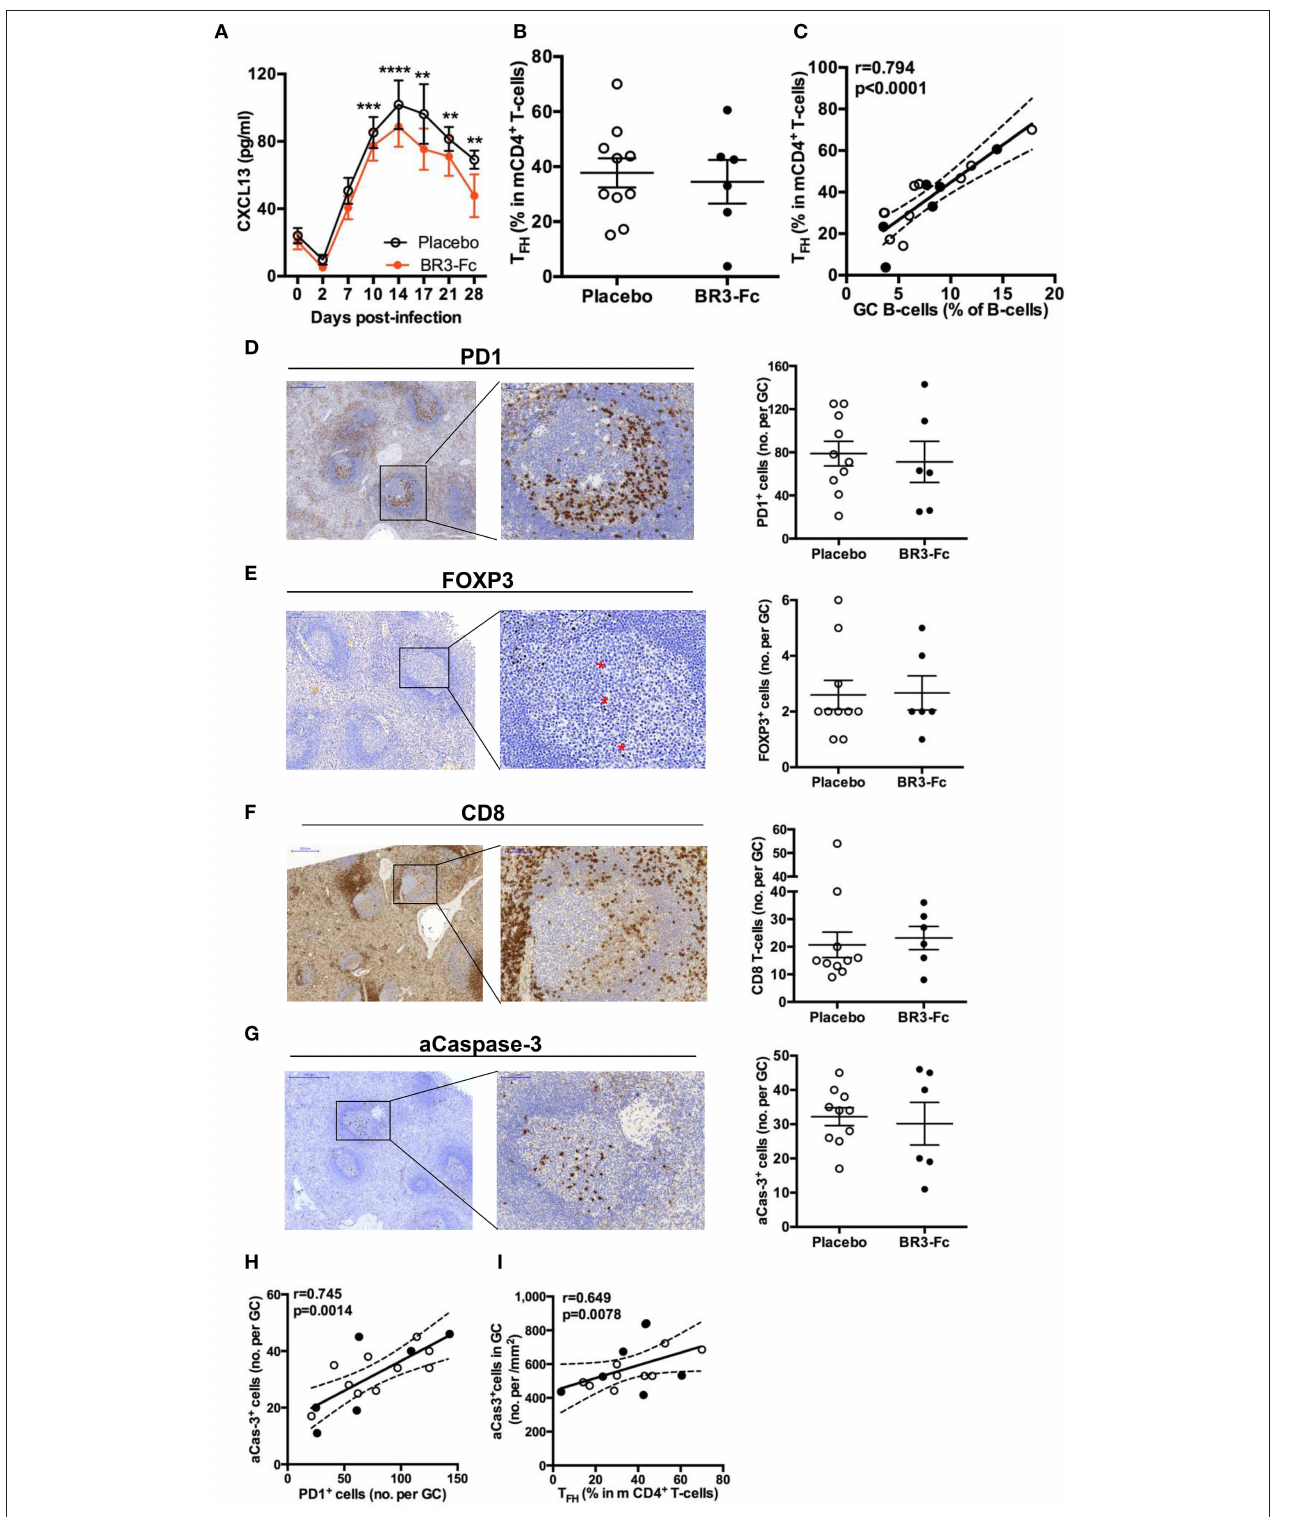
FIGURE 7 | CXCL13 and T FH in spleen of SIV-infected macaques. (A) Serum CXCL13 levels were quantified by ELISA prior to infection (baseline value, D0) and at different time points after infection. Symbols represent the mean value ( ± SEM) for Placebo ( open circle, plain line ) or Treated ( orange circle and line ) group. For